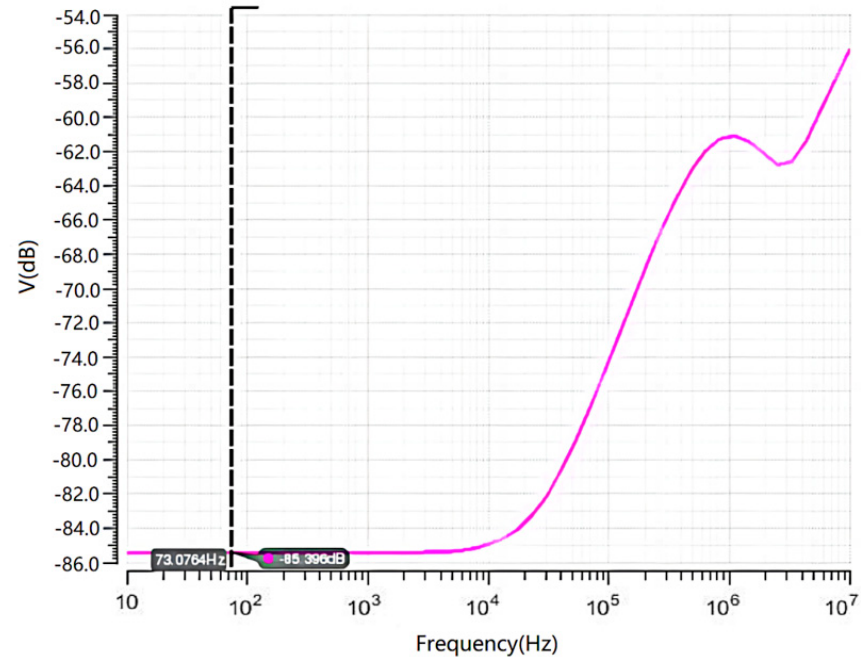
Figure 12. The topology of the reference current circuit.